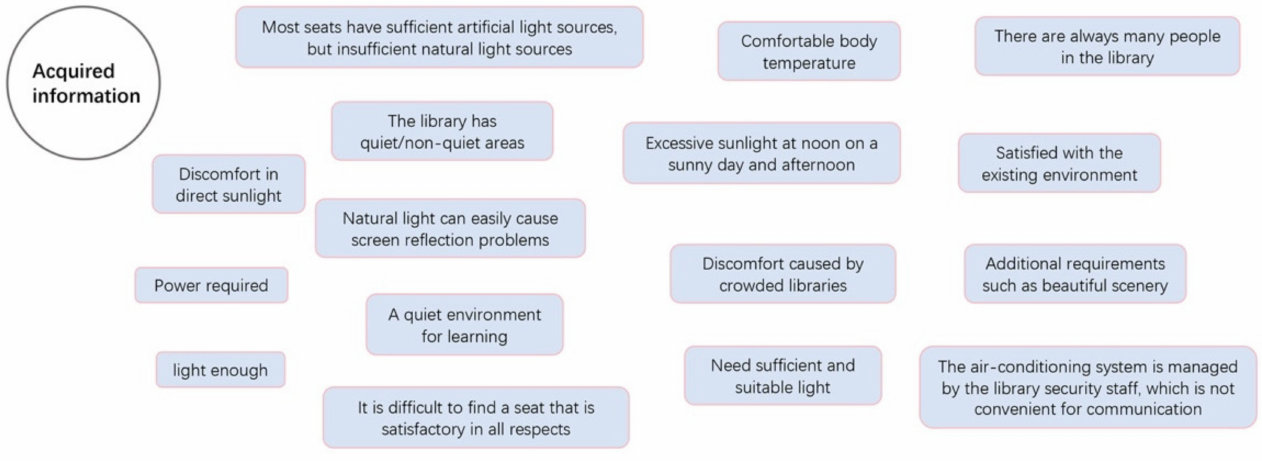
Figure 7. Unclassified information